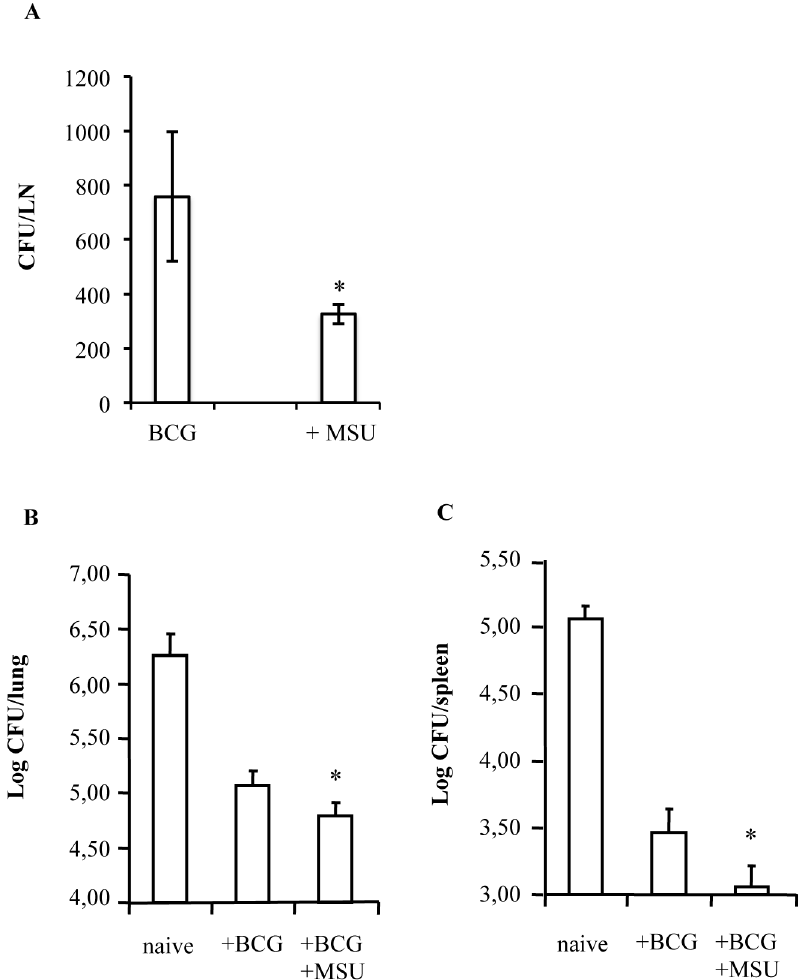
iii) PBS alone. ( A ) Mice were sacrificed after 15 days from immunization and BCG colonies enumerated by the draining axillary lymph nodes. Immunized and control mice were infected 10 weeks post immunization with M . tuberculosis Erdman ( (cid:1) 100 CFU/mouse) by the aerogenic route. Twenty-eight days later, mice were sacrificed and bacterial loads were determined by CFU counting in the lungs ( B ) and spleens ( C ). * p < 0.05 in comparison with BCG vaccinated